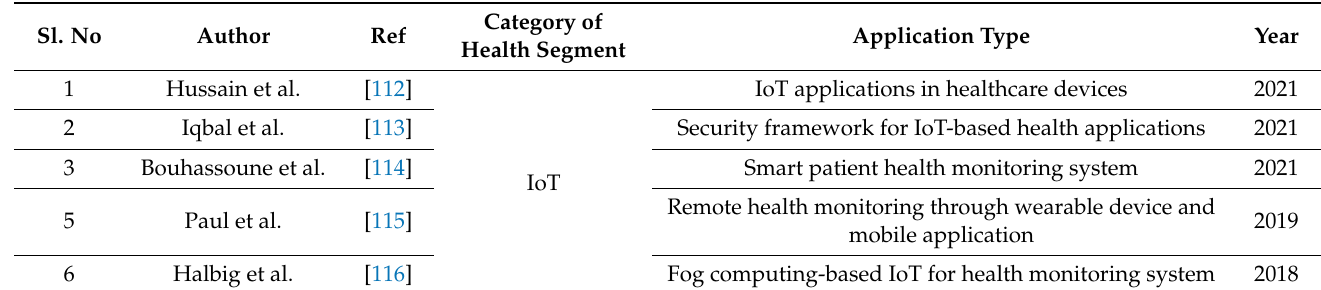
Figure 7. Tele-healthcare IoT medical services to remote patients. Table 5. Review of IoT research work contributions to healthcare